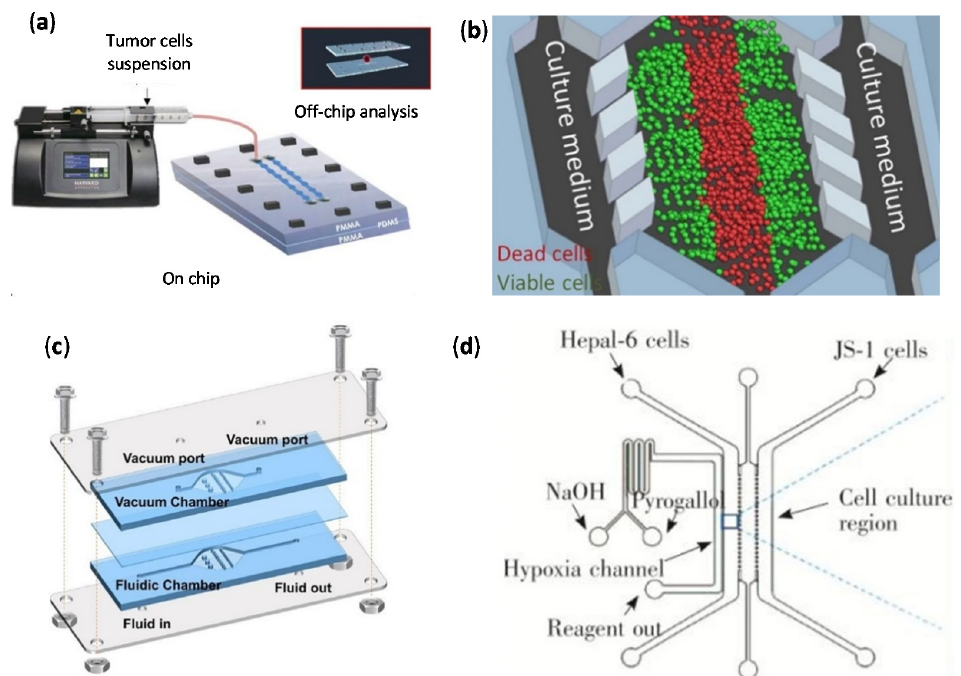
Figure 6. ( a ) Pitingolo et al. [45] developed a cell culture on chip by using a syringe pump to control the flow injection. Adapted with permission from [45]; ( b ) Schematic representation of the culture medium perfusion through the device used by Ayuso et al. [27]. Adapted with permission from [27]; ( c ) Liang et al. [48] developed the bubble trap device schematized. Adapted from [48]; ( d ) Representative diagram of the co-culture chip used by Sun et al. [49] to evaluate the anticancer effects on hepatic healthy and cancer cells. Adapted with permission from [49].